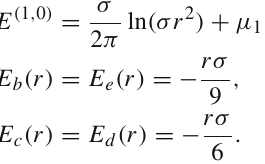
the slope) predicted by the ultrasoft logarithms ∝ ln ( C A α) in E d and E e complies with the lattice data.